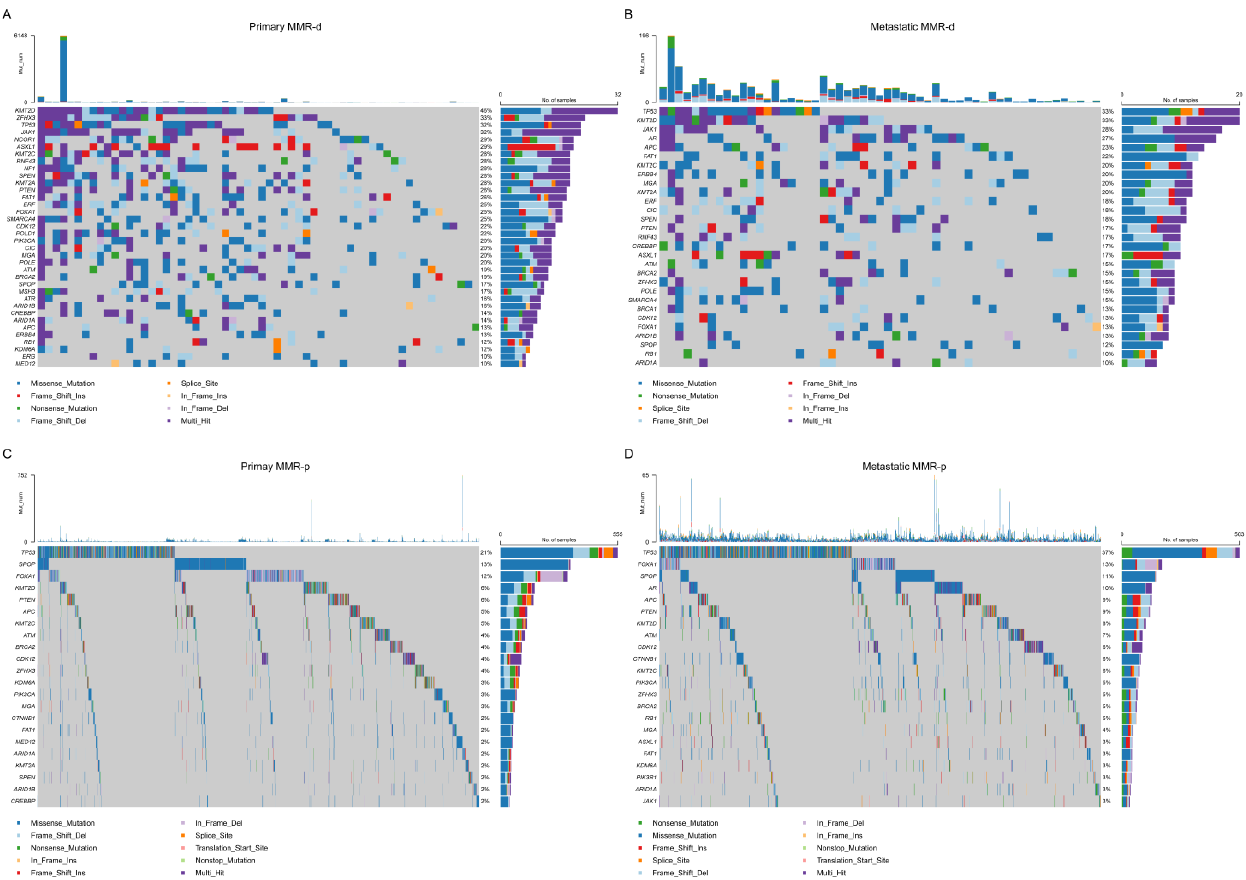
Figure 3. Oncoplot of single nucleotide variants in primary and metastatic MMR-d and MMR-p tumors. Plots correspond to ( A ) primary mismatch repair-deficient tumors, ( B ) metastatic mismatch repair-deficient tumors, ( C ) primary mismatch repair-proficient tumors, and ( D ) metastatic mis- match repair-proficient tumors. Only the most frequently altered candidate genes are shown in the figure. MMR-d = mismatch repair-deficient; MMR-p = mismatch repair-proficient; Del = deletion; Ins =